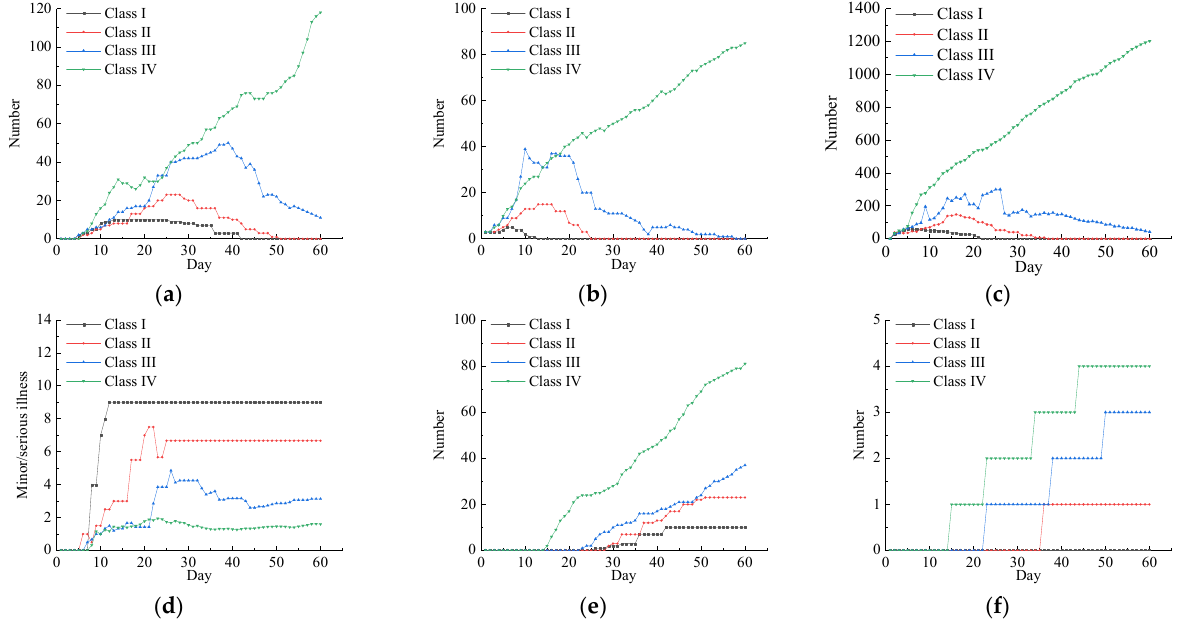
Figure 8. Government response level adjustment scenarios: ( a ) changes in the number of confirmed cases, ( b ) changes in the number of lurkers, ( c ) changes in the number of close contacts, ( d ) mild-to- severe-disease ratio, ( e ) changes in the cumulative number of cured patients, ( f ) cumulative number of